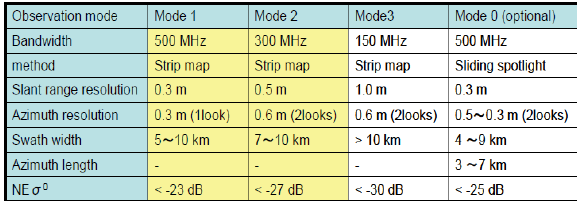
Figure 1. Study area in Riau Province, Sumatera Island, Indonesia